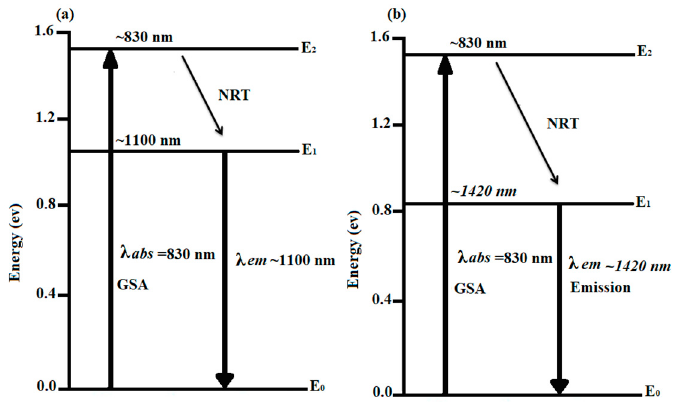
Figure 5. Possible energy levels with 830 nm pumping: ( a ) BAC-Al centre and ( b ) BAC-Si centre. (NRT: non-radiative transition; GSA: ground state absorption).